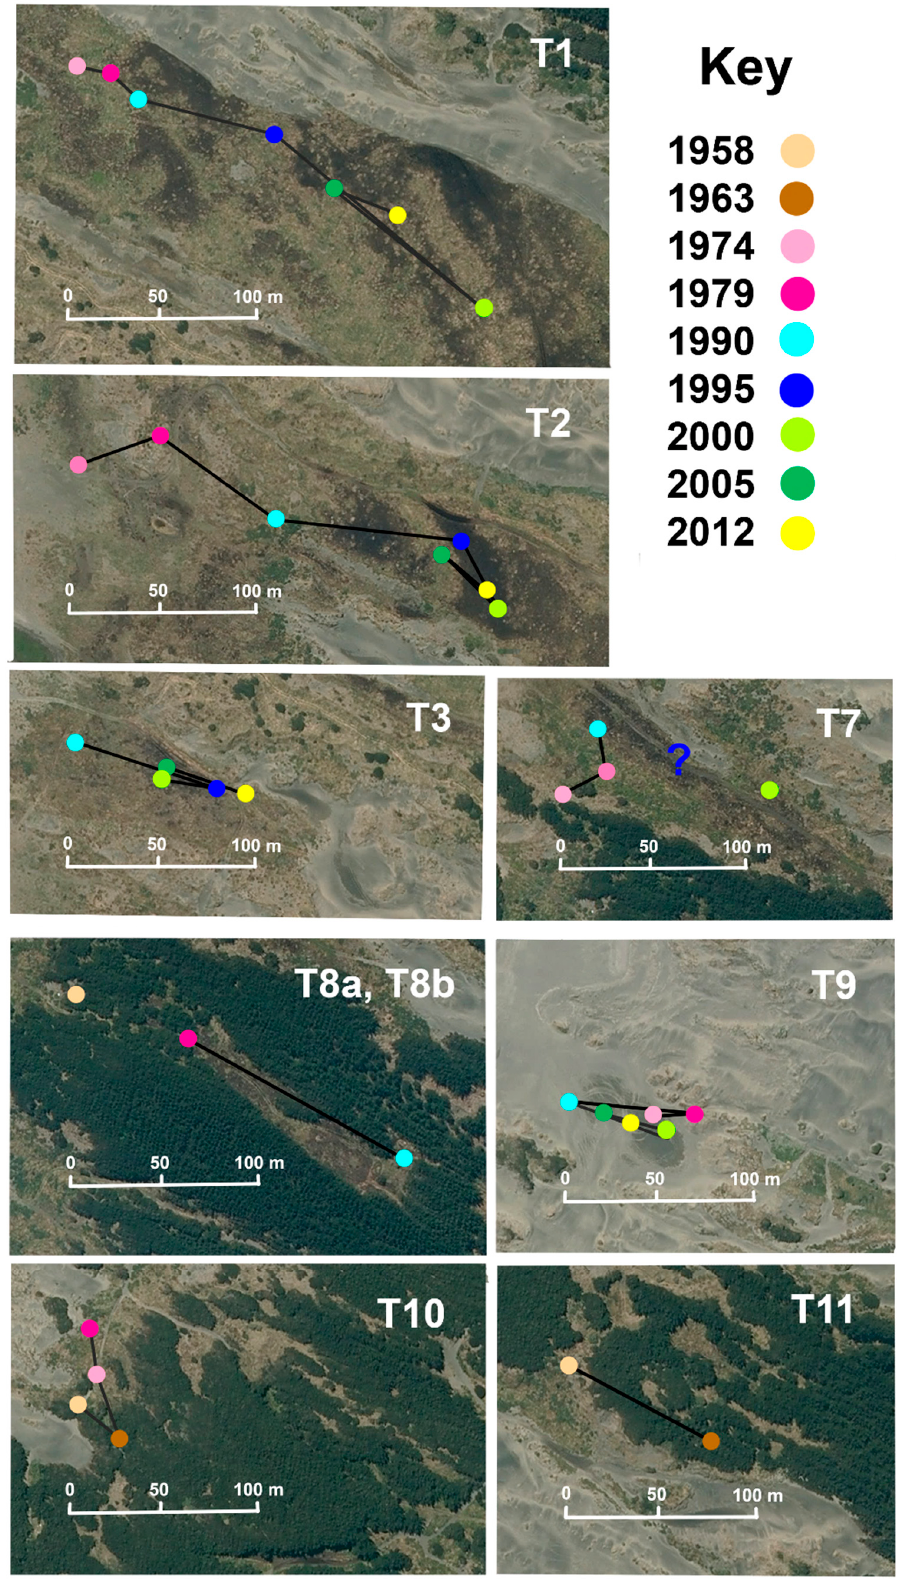
Figure 6. Location and movement of the centroid of each wetland through time for each of the available images at Tangimoana. The aerial photo of 2012 is used as the basal image. For T7, the wetland did not appear in the image of 1995, and its missing situation is indicated by a query sign.